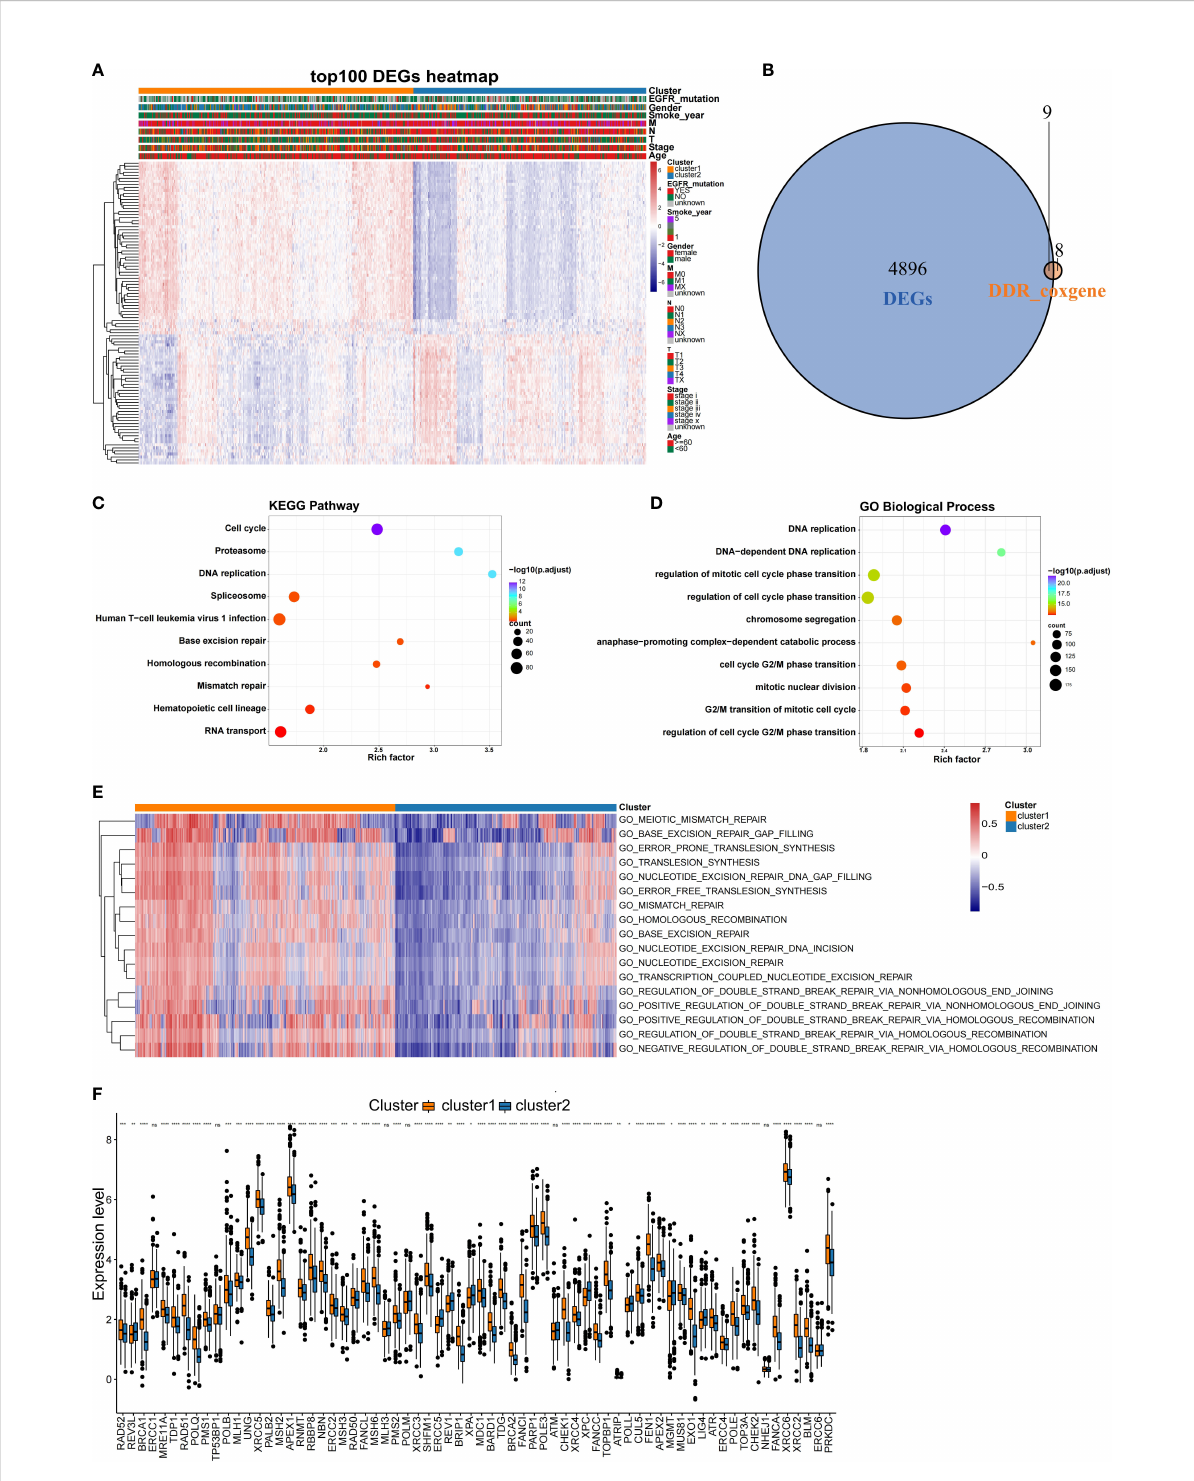
FIGURE 4 Comparison of the molecular characteristics between the NSCLC subtypes. (A) Heatmap of top 100 DEGs expressed in NSCLC subtypes as annotated by clinical features. (B) Venn diagram showing the intersection between the prognosis-related DDR genes and DEGs in the training set. (C) KEGG and (D) GO analysis results of DEGs between the NSCLC subclasses in the training set. (E) Comparison of the DDR pathway and key DDR pathway genes between the NSCLC subclasses. Heatmaps were generated to show the biological processes, in which red indicates activation status and blue indicates inhibition status. (F) Comparison of expression differences of key DDR genes in the two subclasses. *,P < 0.05; **, P < 0.01; ***, P < 0.001; ****, P < 0.0001; ns, no signi fi